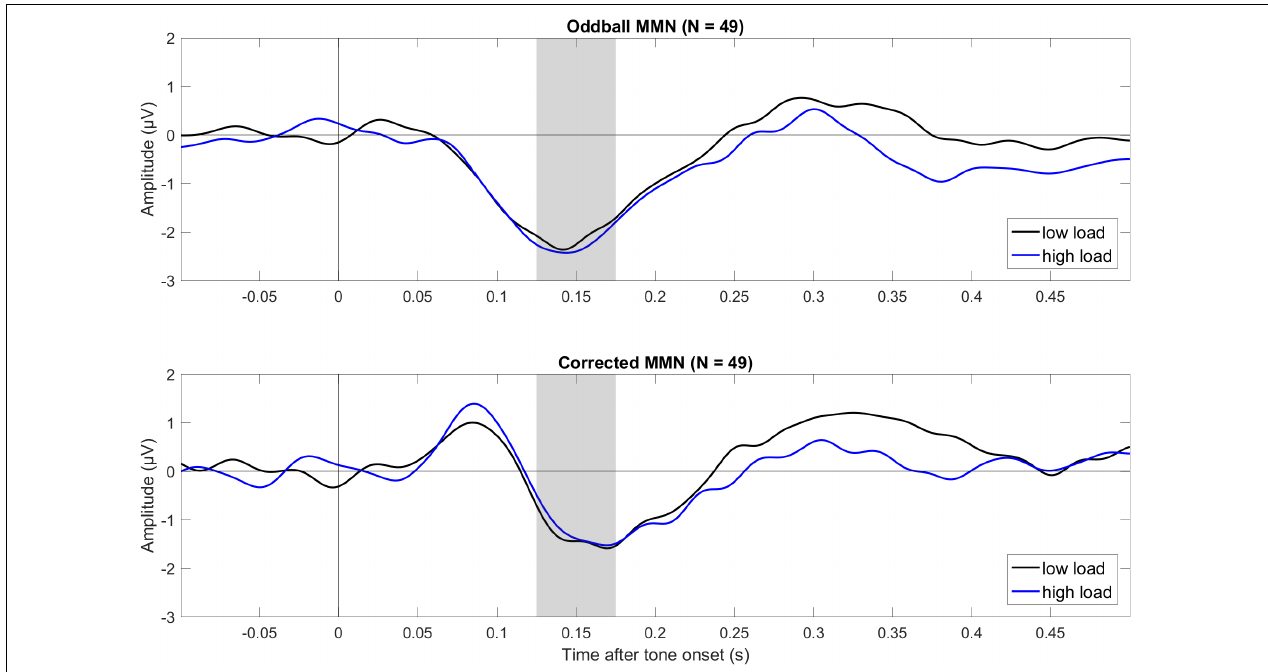
FIGURE 2 | Grand average ( N = 49) ERPs to tone onset for the oddball MMN (top) and corrected MMN (bottom) during low and high visual load (across Fz and Cz). The oddball MMN was the difference between deviant and standard in the oddball condition (deviant minus standard), and the corrected MMN was the difference between deviant in the oddball and the critical tone in the control condition. The gray bars mark the relevant intervals for the MMN. The data were low-pass filtered at 30 Hz.